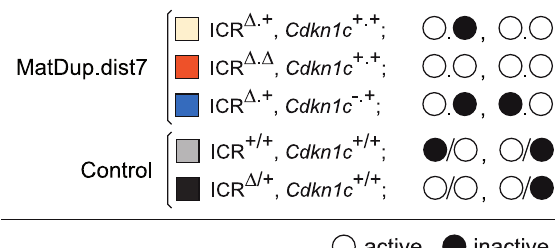
Figure 5. Weight gain in post-partum MatDup.dist7 mice rescued by ICR D . (A) Weight gain in litter matched MatDup.dist7 (ICR D . + , Cdkn1c + . + ) or (ICR D . D , Cdkn1c + . + ) young obtained from matings of (T9H/ + , Tyr c / c , ICR D / + R 6 T9H/ + , Tyr + / + , ICR + / + = ) and (T9H/ + , Tyr c / c , ICR D / + , Cdkn1c + / 2 R 6 T9H/ + , Tyr + / + , ICR + / + , Cdkn1c + / + = ) mice. Each graph represents a single litter where at least one control with the same number of active Igf2 alleles was obtained. Each bar represents a single animal. The paired-sample t -test was used to determine the probability that the weight of MatDup.dist7 and control mice was equal. For three-animal litters, the pairs used in the statistical test are indicated by the bracket above the bars. The P value was , 0.01 for 6 week old mice, indicating a significant difference, while there was no significant difference in weight at 1, 2, and 3 weeks of age. (B) All weight gain data collected from the two sets of matings as described in (A) regardless of littermate matching. Bars are mean 6 s.d., with (n) given above the 1 wk bars. The two-sample t -test was used to determine the probability that two 6 week samples (identified as paired squares) were equal. Key: alleles are maternal.maternal in derivation for MatDup.dist7 and maternal/paternal in derivation for controls.